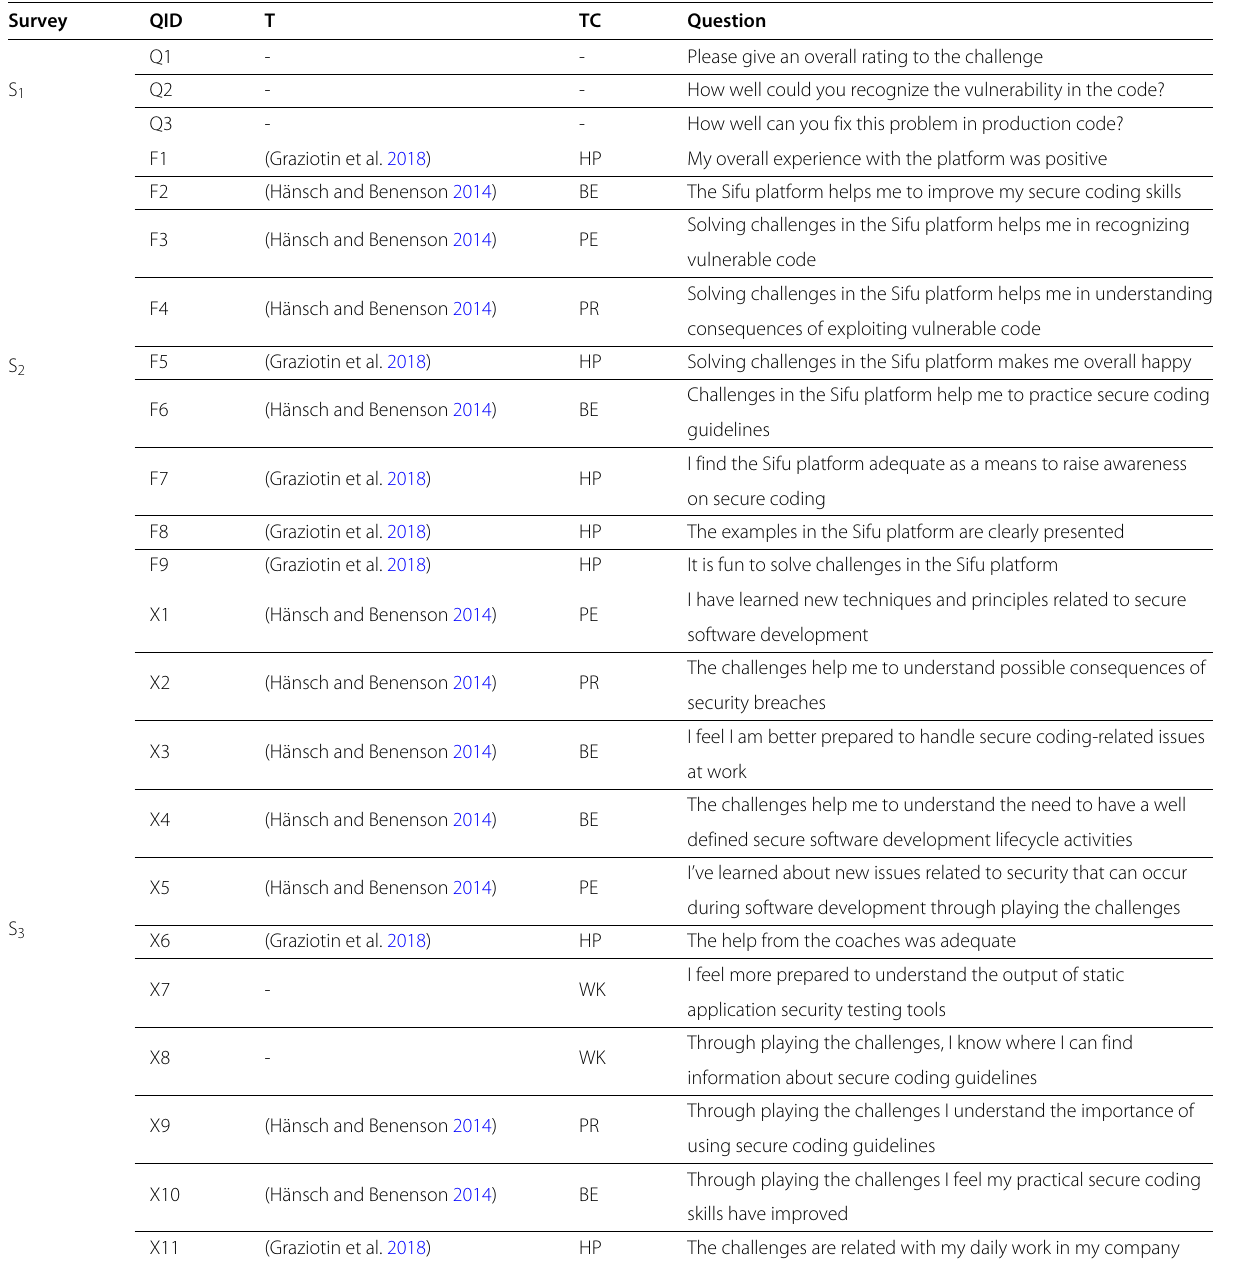
Table 5 Questions for surveys S 1 , S 2 and S 3 Survey